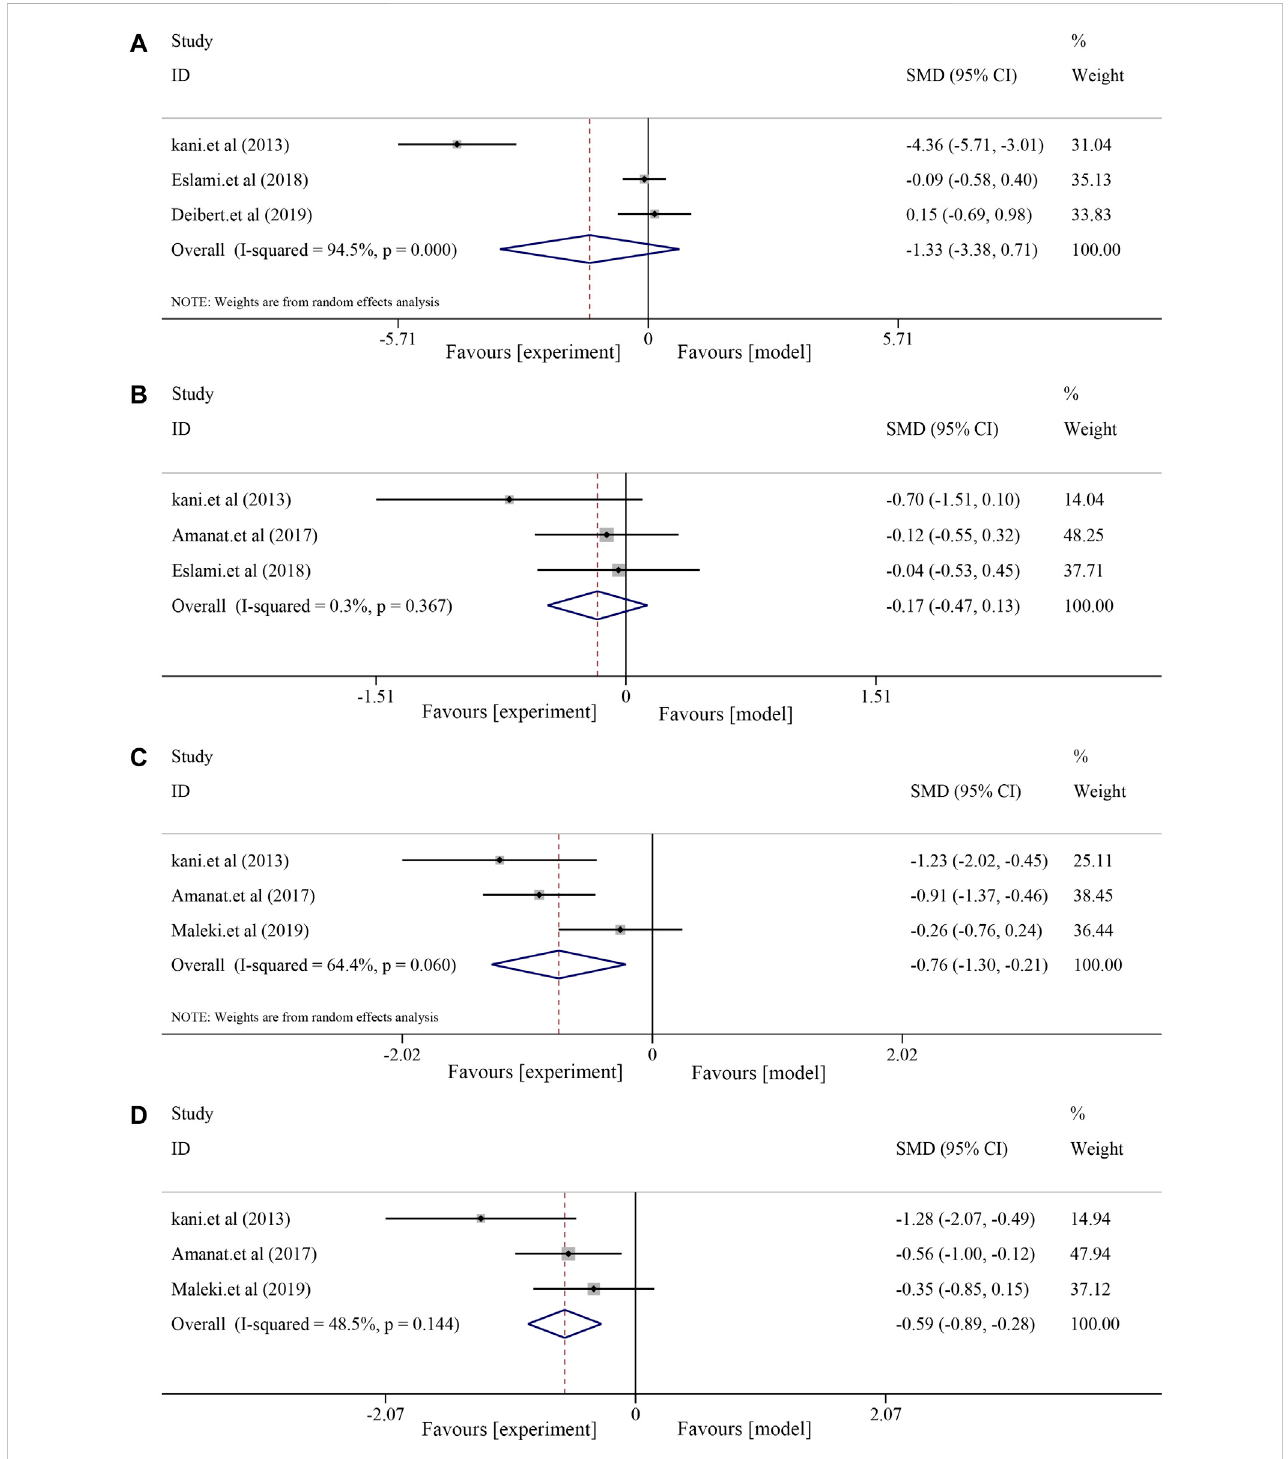
FIGURE 7 Effects of soybean on BW, BMI, MDA, and insulin levels in clinical studies. (A) Pooled effect of BW, (B) BMI, (C) MDA, and (D)